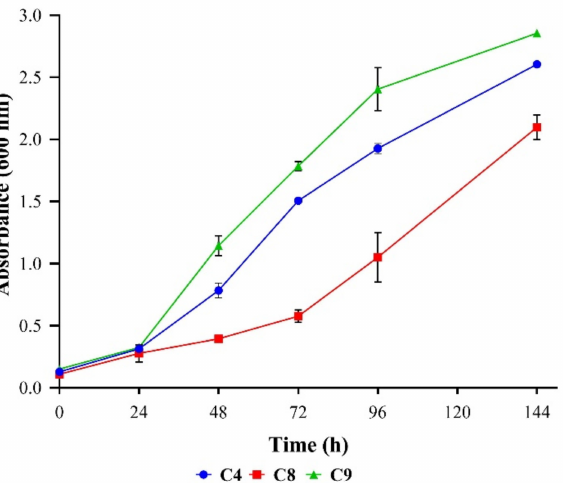
Figure 1. Bacterial growth in BH media with olive oil (2% w / v ) as a carbon source. Data are given as the mean ± SD ( n =